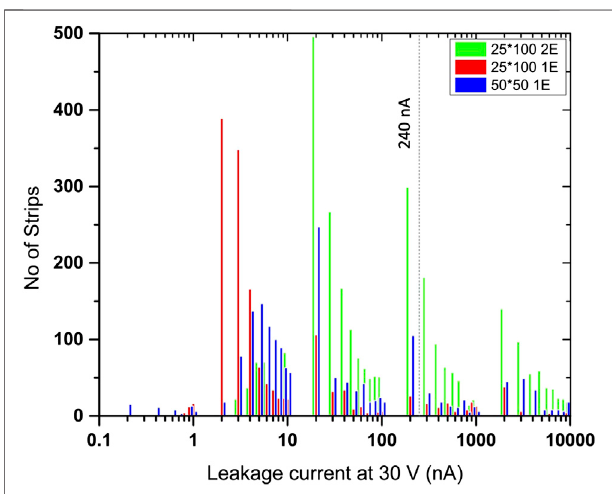
FIGURE 12 | Distributions of leakage current at 30 V reverse bias in all 3D strips (3,840 pixels each) from all wafers of batch 3.